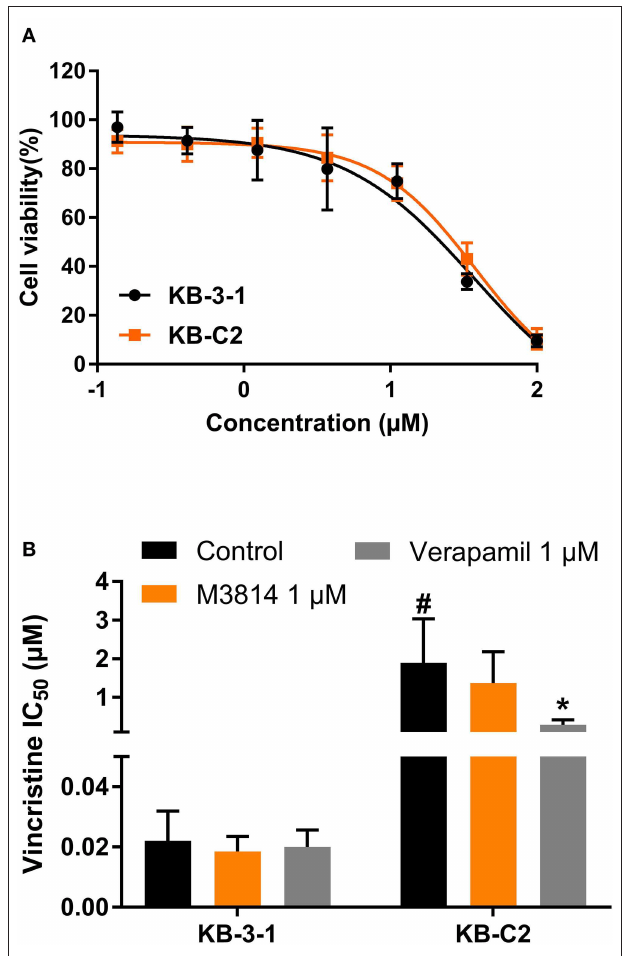
FIGURE 3 | The effect of M3814 on the cytotoxicity of different anticancer drugs in ABCB1-overexpressing cancer cells. (A) Cell viability curves for KB-3-1 and KB-C2 cells; (B) The effect of M3814 on the cytotoxicity of vincristine. Data are expressed as mean ± SD from a representative of three independent experiments. * p < 0.05 vs. the control group. # p < 0.05 vs. the control group in parental cell